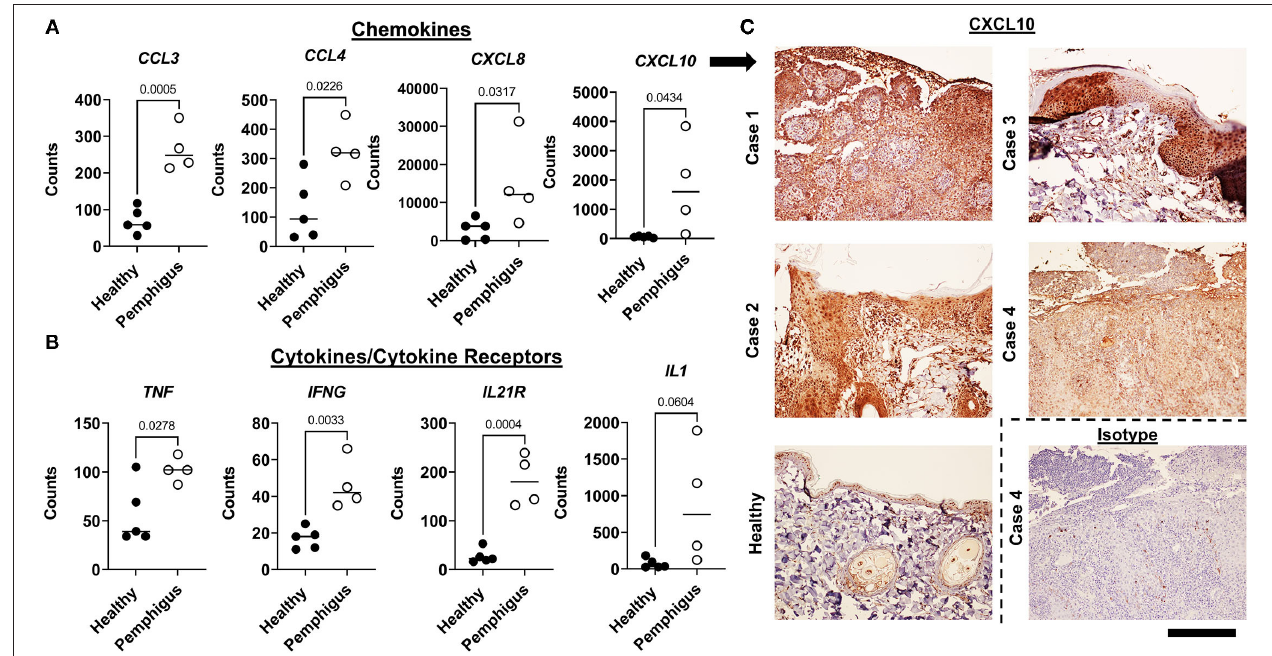
FIGURE 2 | Examination of key inflammatory gene expression in canine pemphigus variants reveals conserved patterns similar to previously published human pemphigus datasets. (A) Gene expression of chemokines and (B) cytokines/receptors in canine skin biopsies that were previously identified to be upregulated in human pemphigus [Mann-Whitney U -tests (non-normally distributed data) and student’s two tailed t -tests (normally distributed data) significant as indicated; n = 4 pemphigus and 5 healthy margins]. (C) Confirmation of CXCL10 expression with IHC in cases vs. healthy and isotype controls. 100x, Scale bar = 300 µ